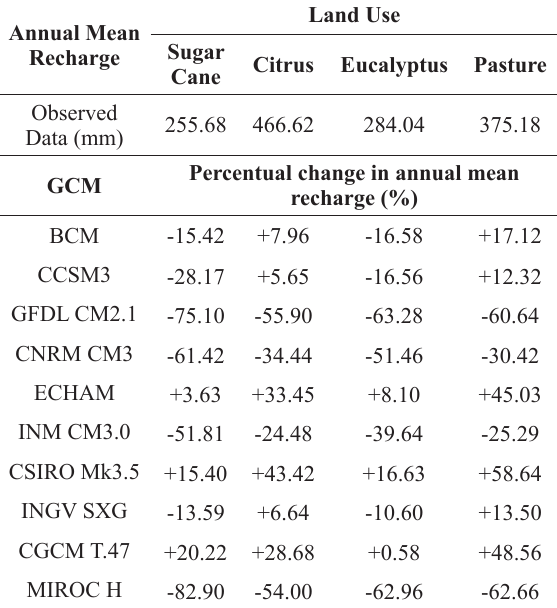
Annual mean recharge calculated by the water budget using observed data and percentual change in mean recharge for future